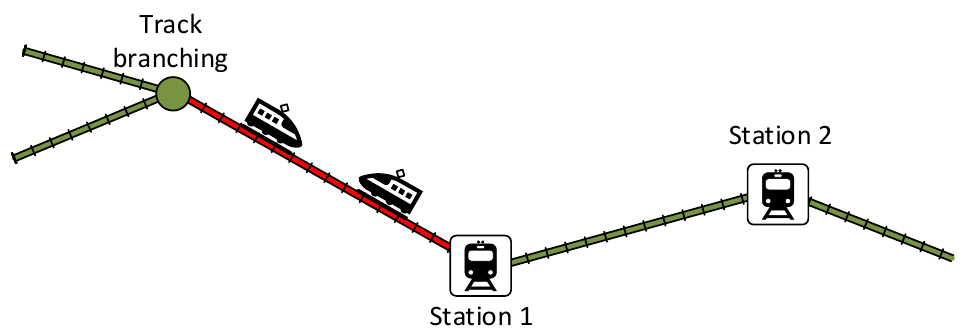
Figure 14. Illustration of detection of two vehicles occurring at an identical edge.